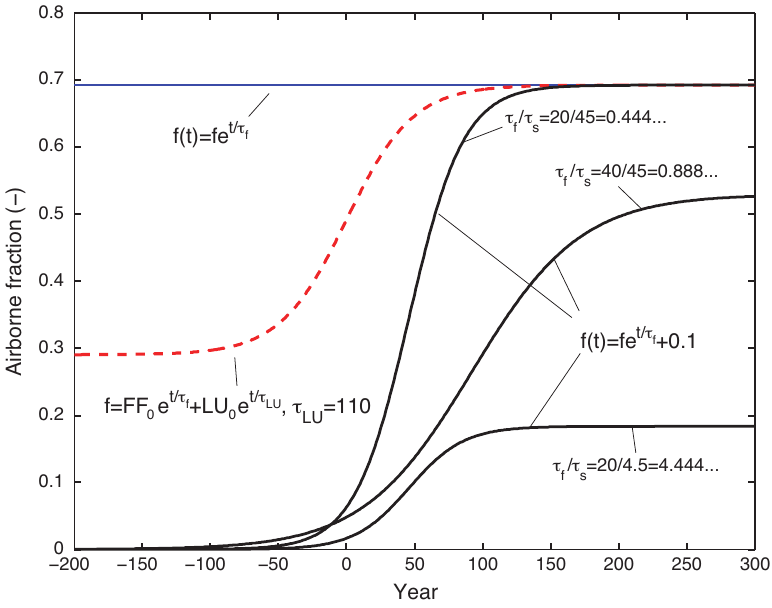
Fig. 2. Predicted air-borne fraction for a range of forcings including purely exponential forcing f (t) = f e t/τ f (blue), mixed exponential and constant forcing f (t) = f e t/τ f + f 0 with f 0 = 0 . 1 (black), and forcing by the sum of two exponential functions, f (t) = f e t/τ f + f LU e t/τ LU (red). If the forcing is not exactly exponential, then the time-scale for convergence is roughly on the order 160 of 200-300 years (Fig. 2), depending on the exact functional form of the forcing.